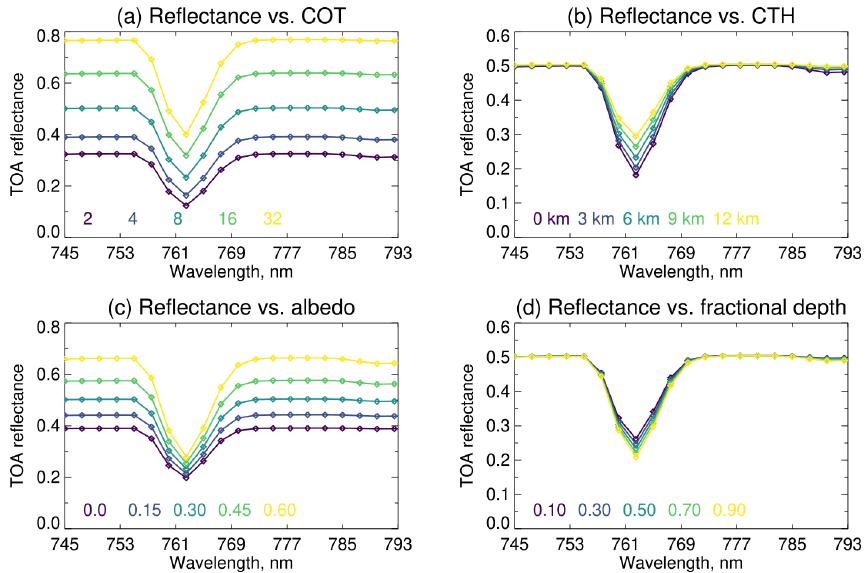
Figure 2. TOA reflectance for selected OCI channels (diamonds) as a function of cloud and surface properties. The base simulation is for a liquid water cloud with CER of 10µm and mid-visible COT of 8. The CTH is 6km, and the fractional depth (i.e. fraction of the altitude between the CTH and ground level) of the vertically homogeneous cloud is 0.5 (i.e. cloud base of 3km, cloud geometric thickness of 3km). Simulations also include Rayleigh scattering and a spectrally flat Lambertian surface with albedo of 0.3. All simulations are otherwise as described for the set-up used for Fig. 1. Panels show the variation in TOA reflectance when (a) COT, (b) CTH, (c) surface albedo, or (d) fractional depth are varied and all other parameters held constant. Coloured parameter values at the bottom of each panel correspond to the coloured lines.